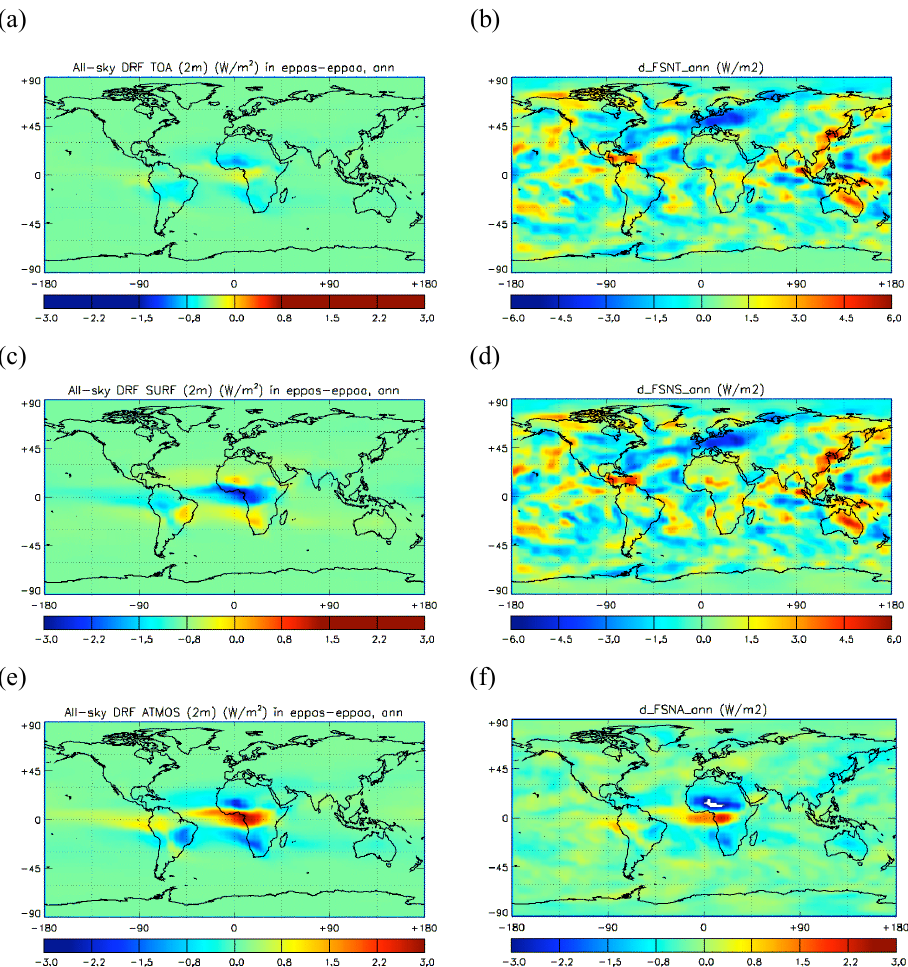
Fig. 6. Comparison of global distribution of differences in annual DRF (W/m 2 ) caused by seasonality of BBCA emissions derived from the offline (the left column) and online runs (the right column) at the top of the atmosphere ( a and b ), at the surface (c and d), and in the atmosphere ( e and f ),